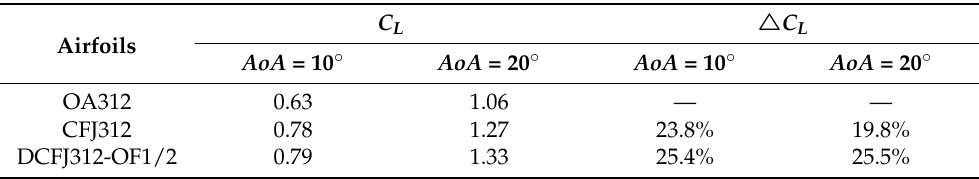
Table 3. Comparisons of lift coefficients of DCFJ312 and CFJ312 airfoils at typical AoA s.